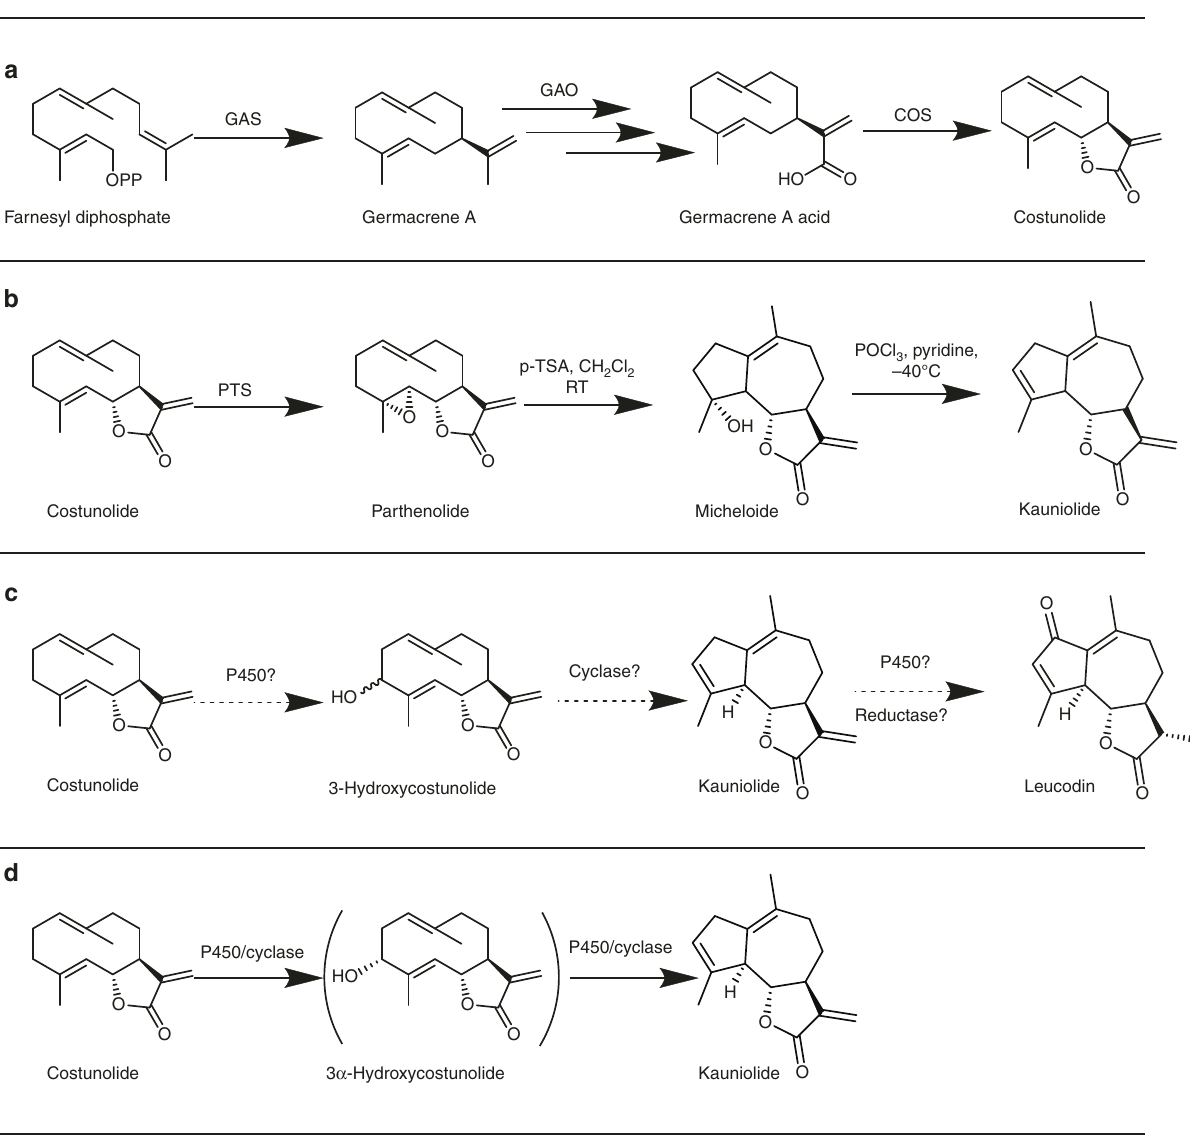
Fig. 1 Biosynthetic pathway of costunolide and proposed (bio)synthetic pathways for kauniolide. a Biosynthetic pathway of costunolide 13 . b Conversion of costunolide to parthenolide by PTS 14 and chemical biomimetic synthesis of kauniolide from parthenolide 15 . c Proposed biosynthesis of kauniolide 17 and proposed biosynthetic pathway of leucodin in chicory 2 . d Biosynthetic pathway of kauniolide, through 3 α -hydroxycostunolide as intermediate, as identi fi ed in the present study. GAS germacrene A synthase, GAO germacrene A oxidase, COS costunolide synthase, PTS parthenolide synthase, p-TSA p-toluene sulphonic acid, CH 2 Cl 2 dichloromethane, RT room temperature, POCl 3 phosphoryl